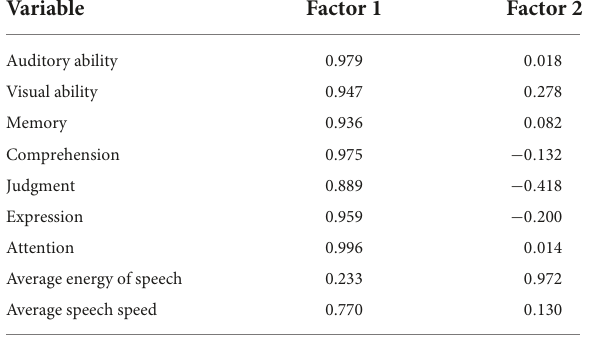
TABLE 6 Factor loading matrix. TABLE 7 Comparison of assessment results for different ability levels ( n = 50).